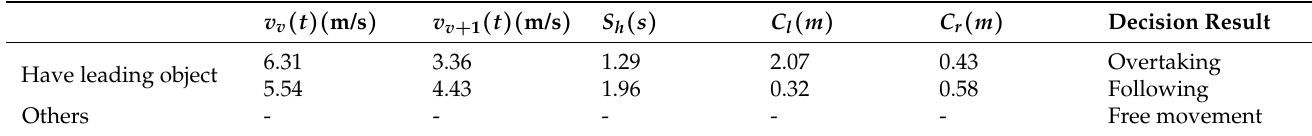
Table 1. Numerical examples of decision-making algorithms.